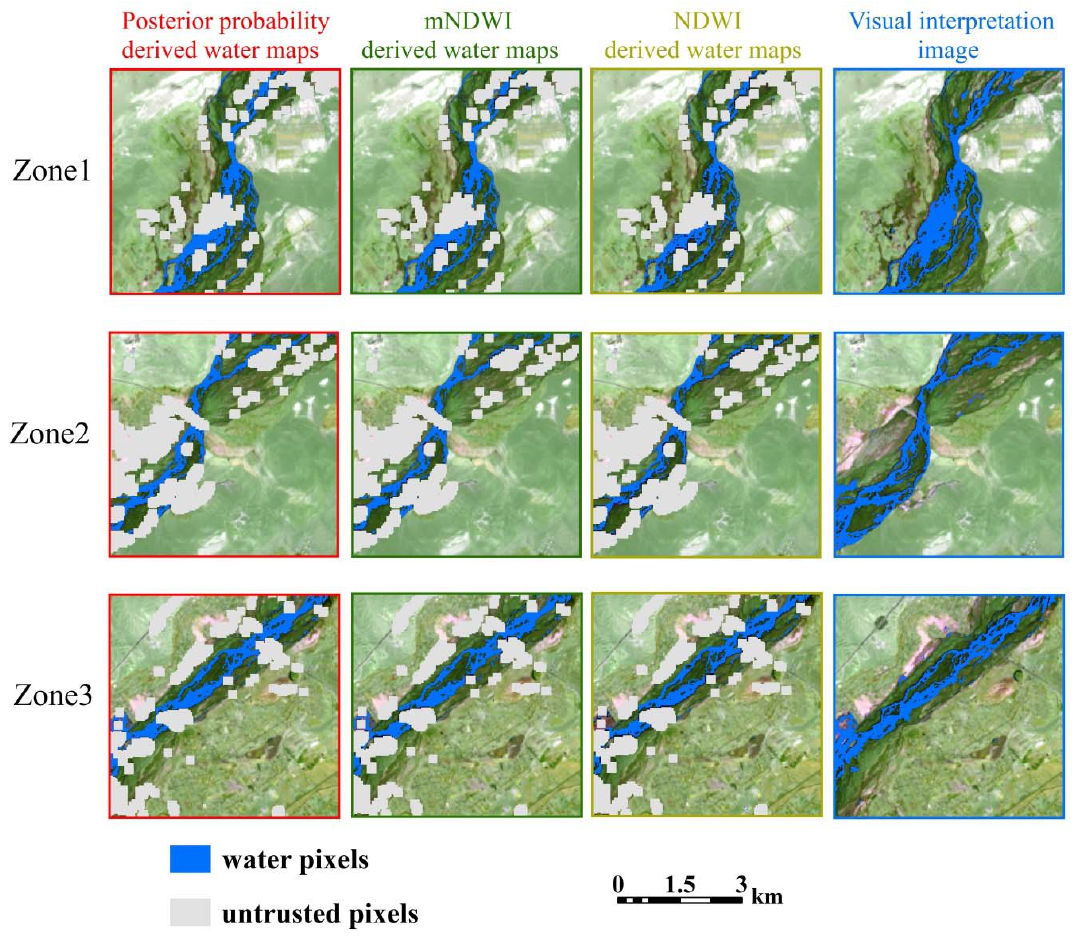
Figure 10. Binary water maps derived from posterior probability, mNDWI, NDWI, and Sentinel-2 visual interpretation of three demonstration zones in the Zhengyixia reach. Table 3. Accuracy indices of three water maps derived from different methods for The Zhengyixia Reach.